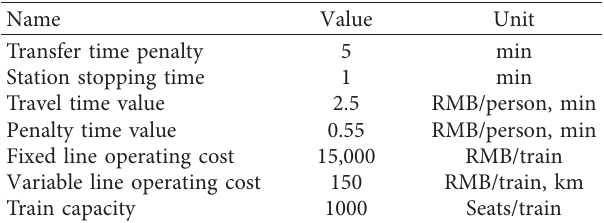
Table 1: Data of the small example